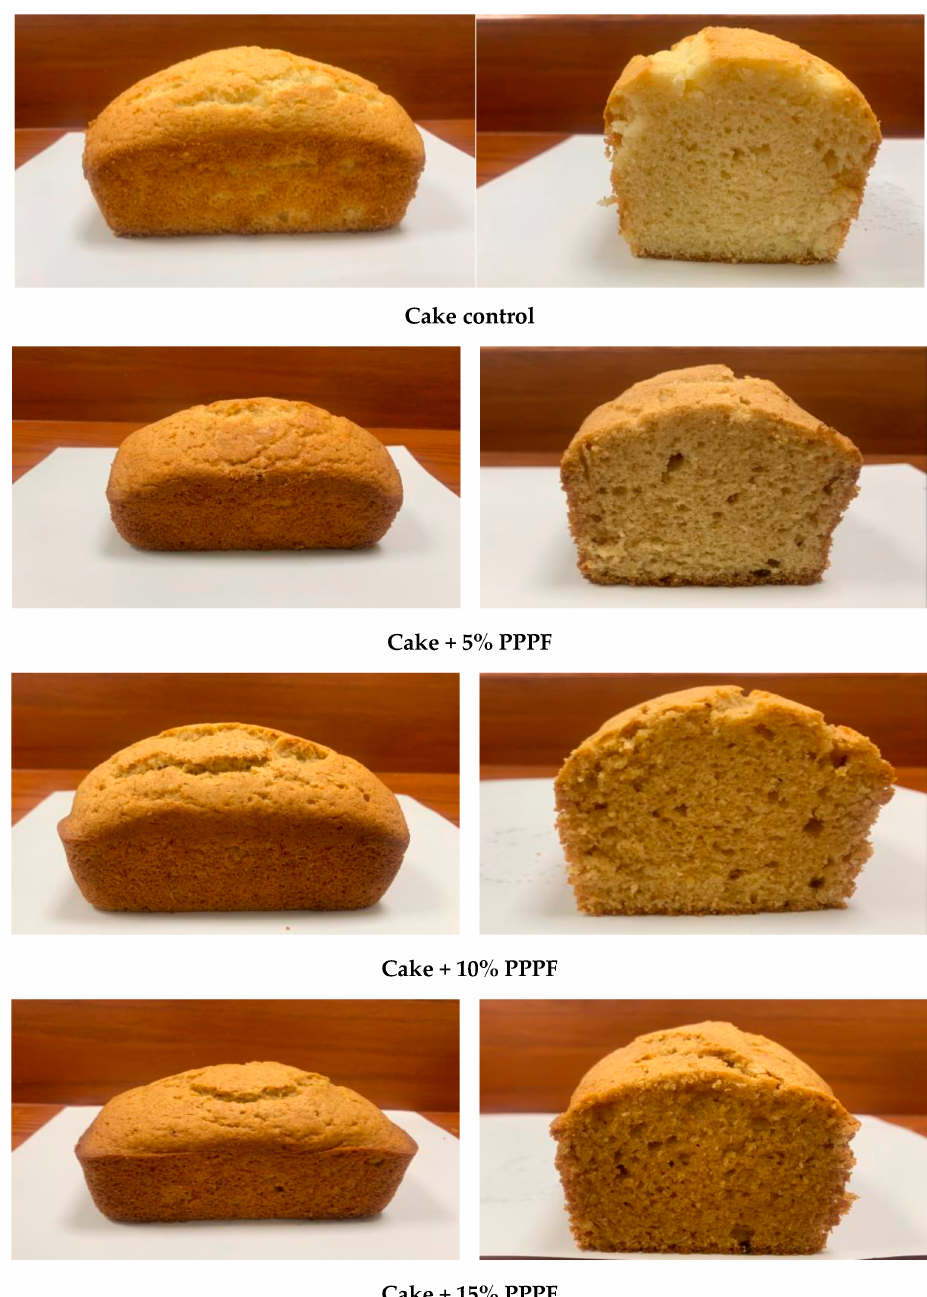
Figure 7. The whole cake and sullied cakes were prepared by replacing flour with various levels of